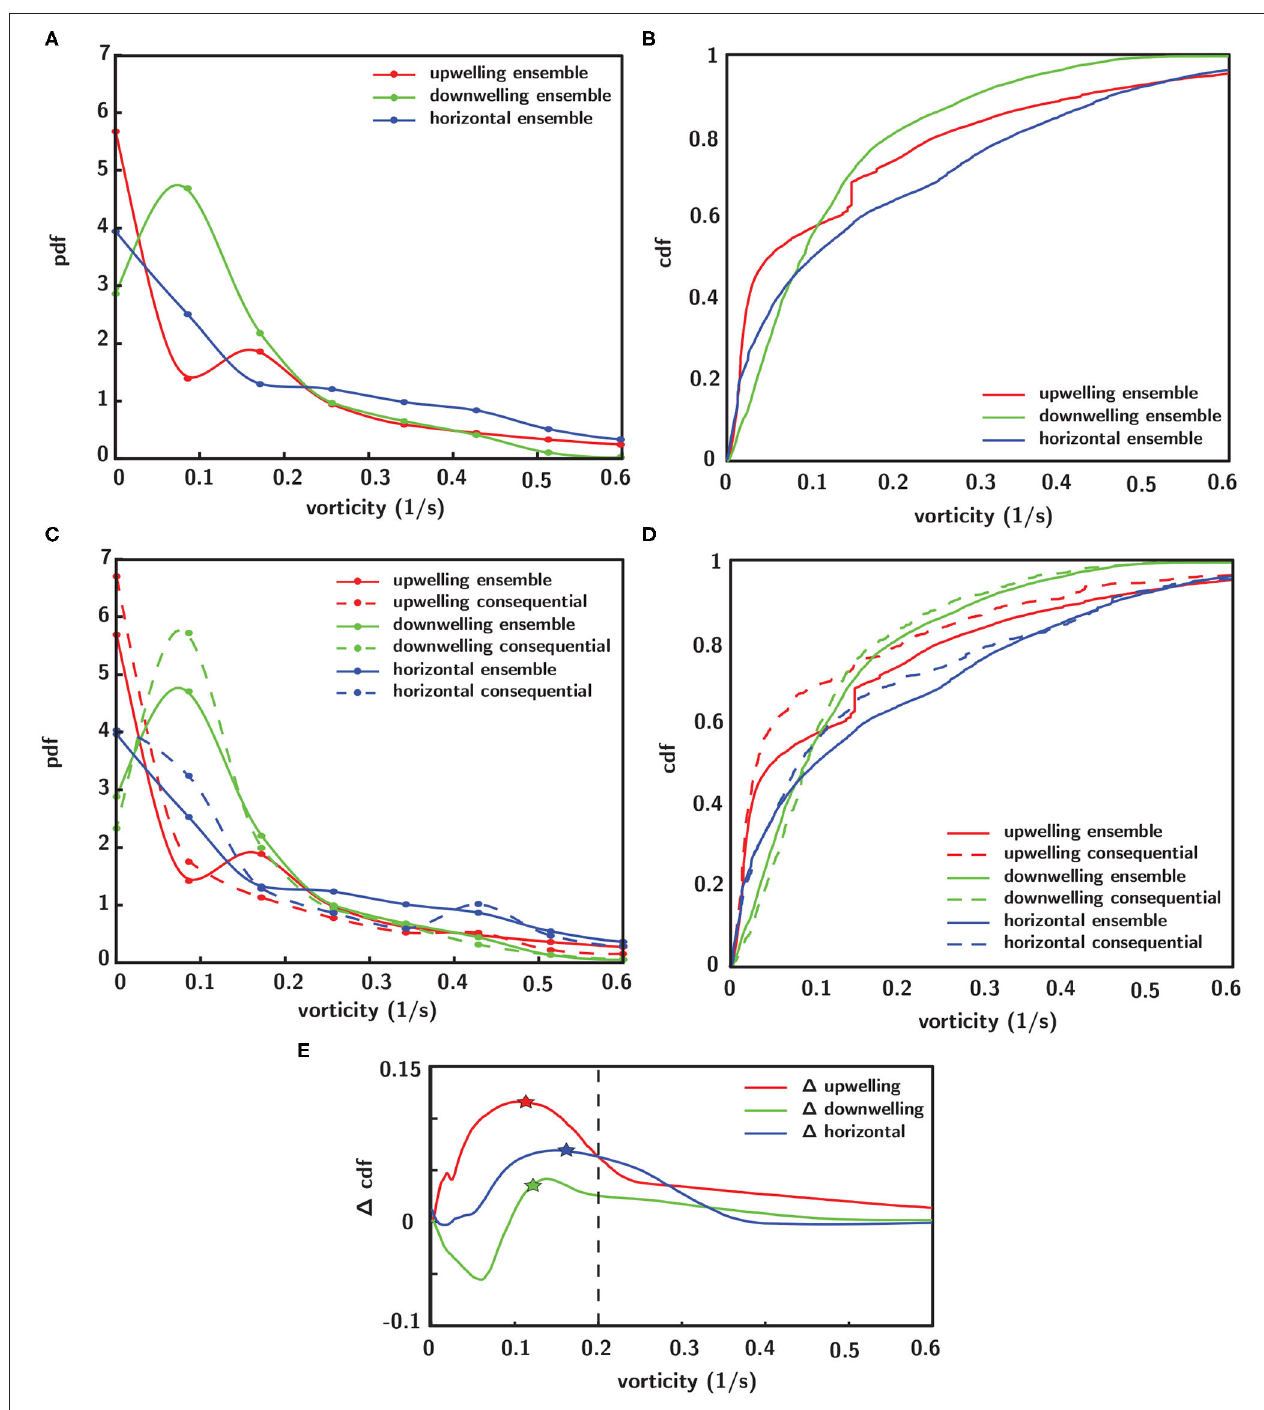
FIGURE 10 | Empirical probability (pdf, A ) and cumulative (cdf, B ) distribution functions of the ensemble of all vorticity values encountered by larvae in each shear flow orientation. (C) Pdfs of fluid vorticity magnitudes eliciting consequential behavioral responses (see text for definition of “consequential”) in each shear flow orientation (dashed lines) in addition to ensemble distributions (solid lines). (D) Corresponding cdfs of consequential (dashed lines) and ensemble (solid lines) vorticity. (E) Difference in cumulative probabilities of consequential and ensemble vorticity cdfs (dashed–solid lines from D ), where stars indicate the average values of the consequential behavior vorticity pdfs (dashed lines in C , Table 1 ) and the black dashed line at 0.2 s − 1 corresponds to the common vorticity value chosen to delineate in-layer vs. out-of-layer regions for the ANOVAs.